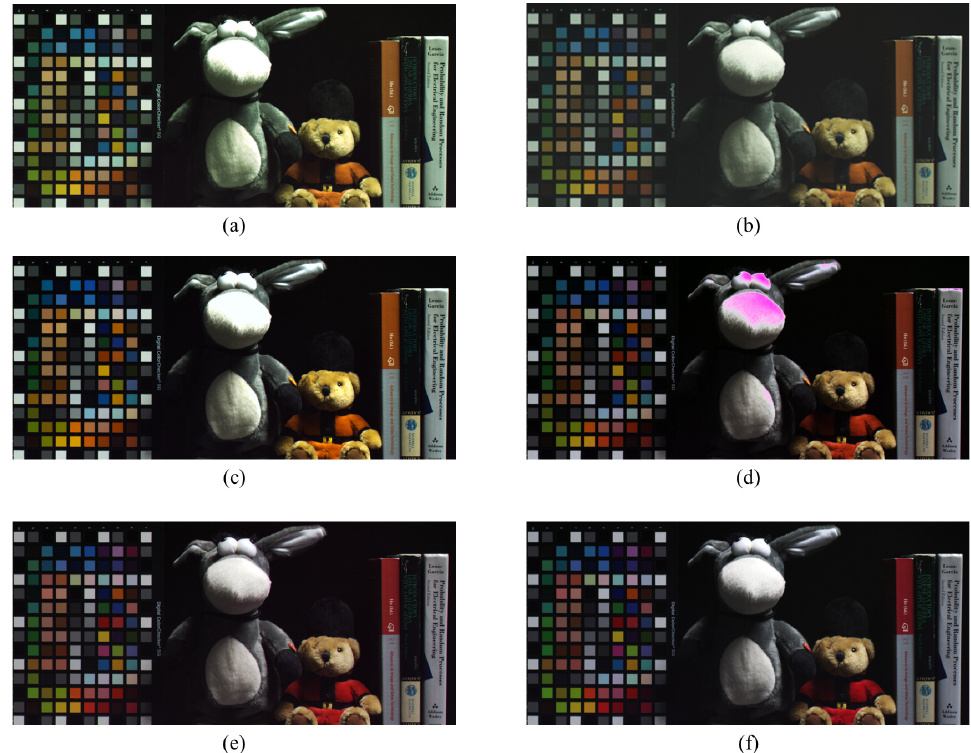
Figure 8. Experimental results (fluorescent lamp): ( a ) RWB image before RGB color conversion without double-exposed W; ( b ) RWB image before RGB color conversion with double-exposed W; ( c ) Color correction of (a) by color transfer; ( d ) Color correction of (a) by applying CCM; ( e ) RGB color image (target image); and ( f ) Proposed method with